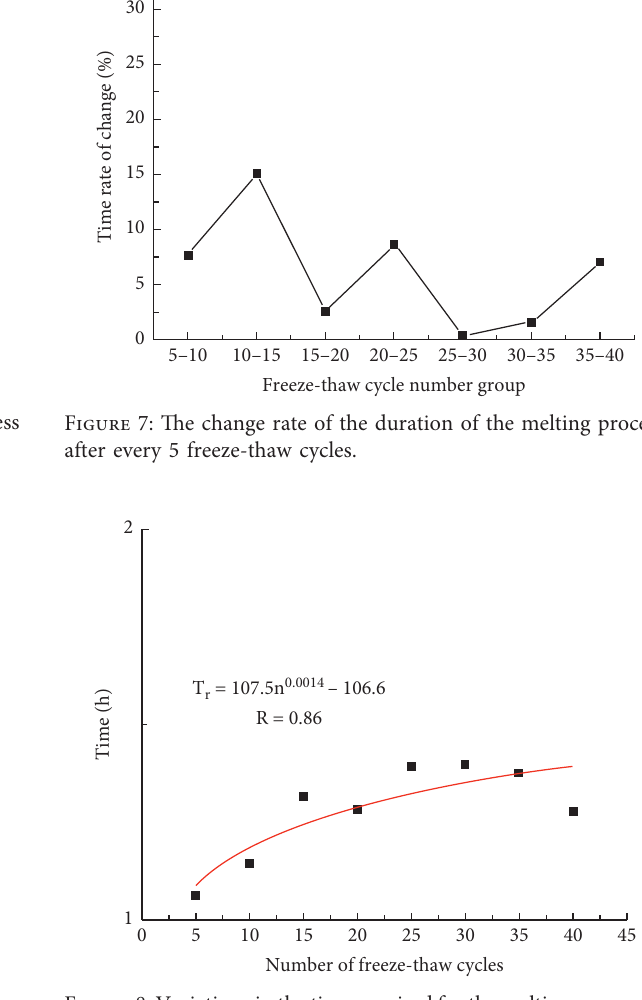
Figure 6: Time required for the freeze process as a function of freeze-thaw cycles.